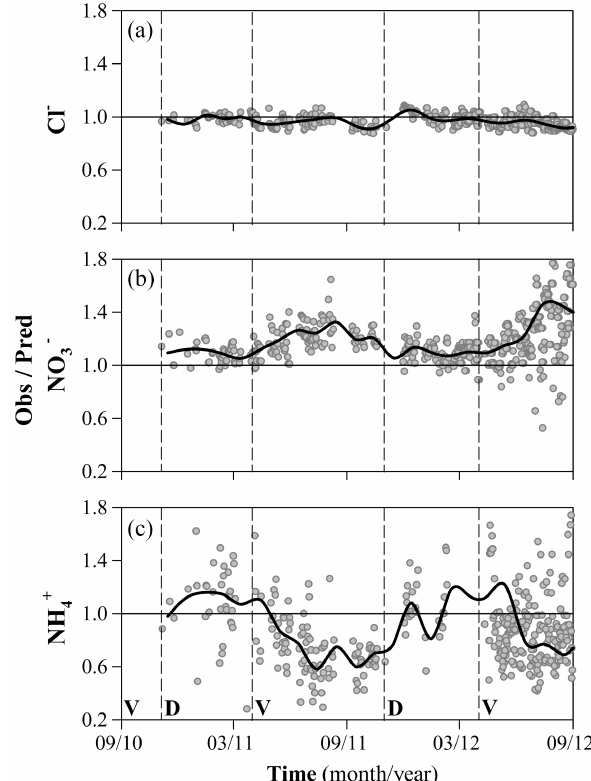
Figure 4. Temporal pattern of the ratio between observed stream solute concentrations at the bottom of the valley reach (downstream site) and those predicted from hydrological mixing for (a) chloride, (b) nitrate, and (c) ammonium during the period 2010–2012. Bold lines indicate the running median (the half-window is 7 days). The Obs:Pred = 1 line is indicated as a reference. V: vegetative period, D: dormant